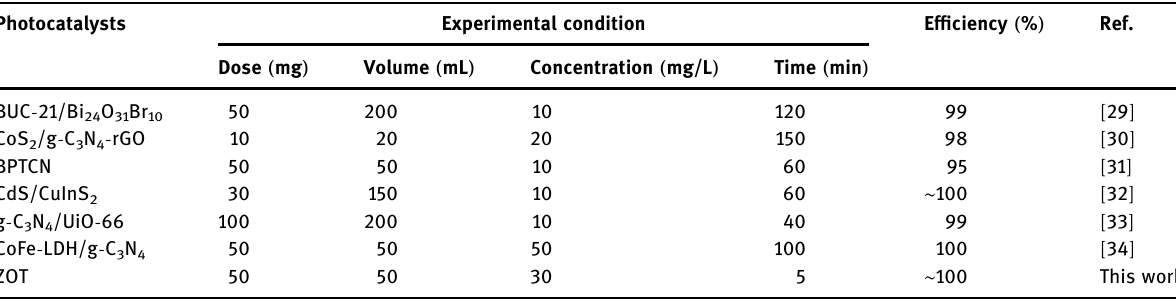
Table 1: Comparative performance for photocatalysts for Cr reduction Photocatalysts Experimental condition E ffi ciency ( % )